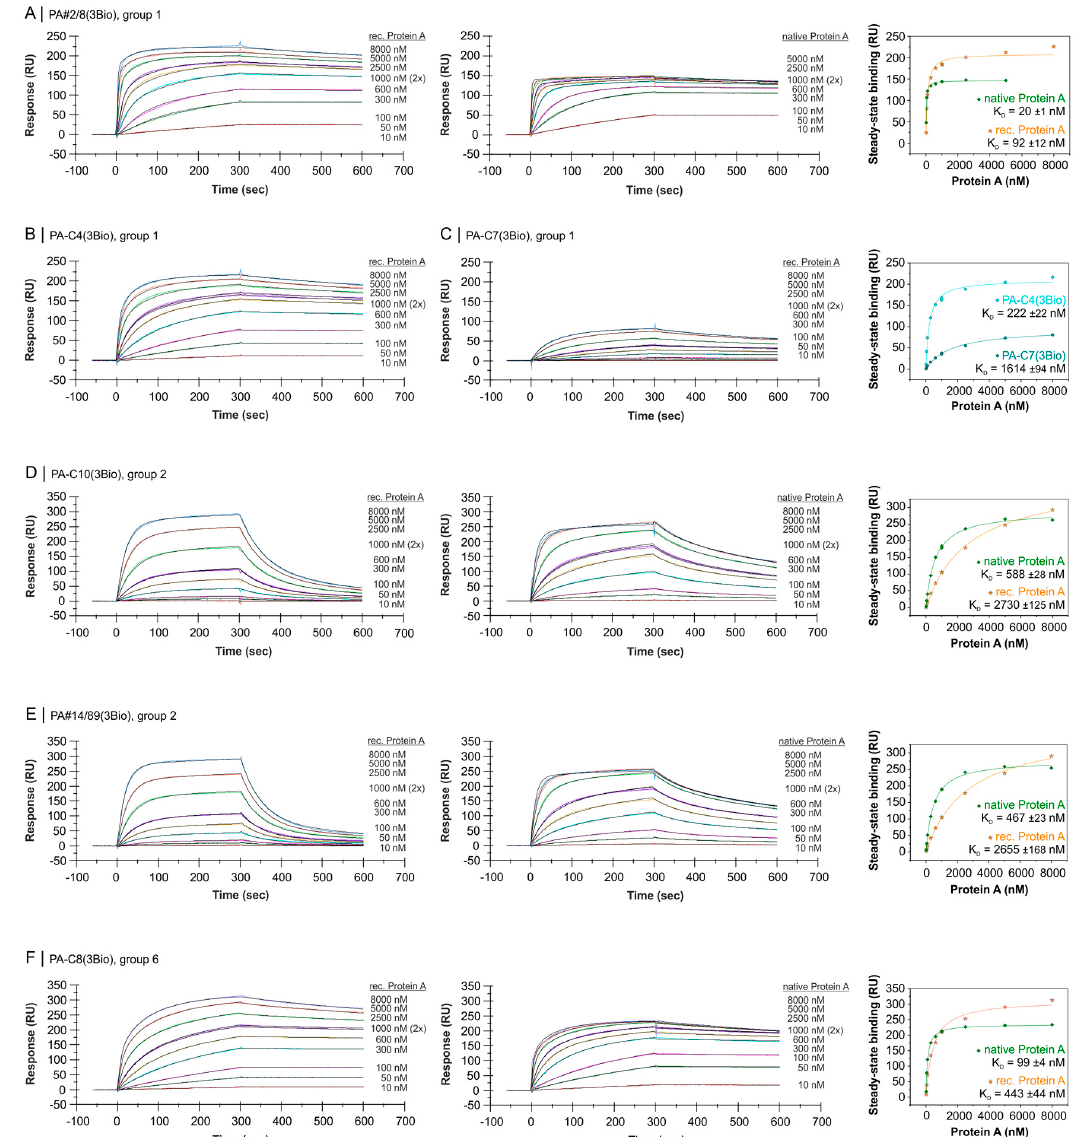
Figure 6. SPR-based interaction analyses with the Biacore X100 instrument regarding the affinity of aptameric sequences from group 1 ( A – C ), 2 ( D , E ) and 6 ( F ) to Protein A. Biotinylated aptamers were immobilized via the 5 ′ - or 3 ′ -end on the streptavidin-modified sensor surface and a concentration series of recombinant or native Protein A was applied for binding. Black lines represent the fit to bivalent analyte binding model (group 1 and 6 aptamers) or to two state reaction model (group 2 aptamers). The corresponding plots of steady-state binding data from the end of the association phases against analyte concentrations were used to calculate the steady-state affinities ( K D ).